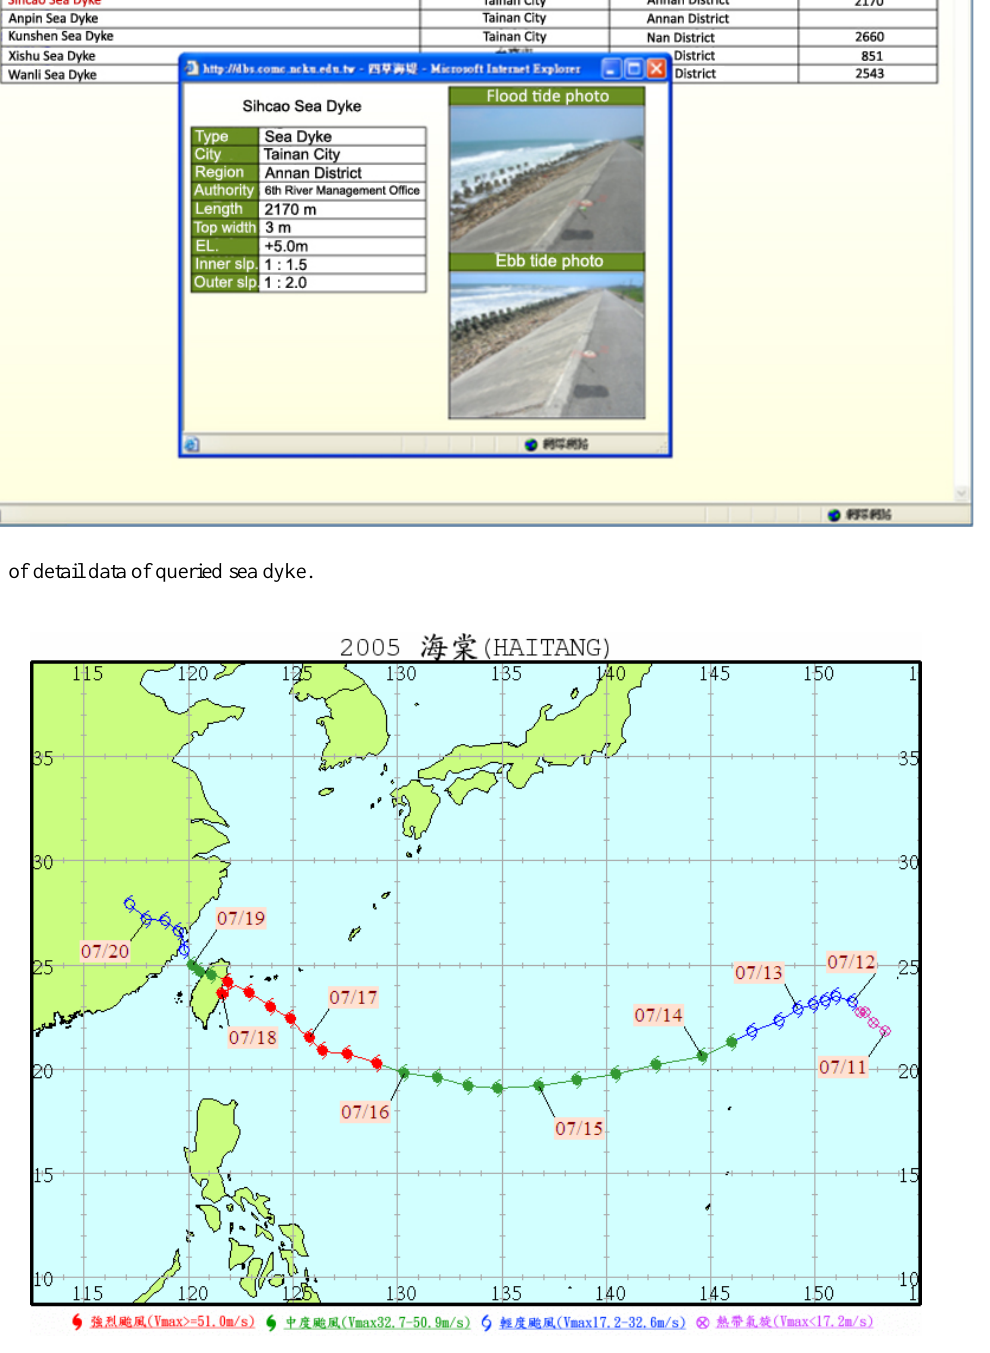
Figure 15 Track of typhoon Haitang in 2005 Fig. 15. Track of typhoon Haitang in